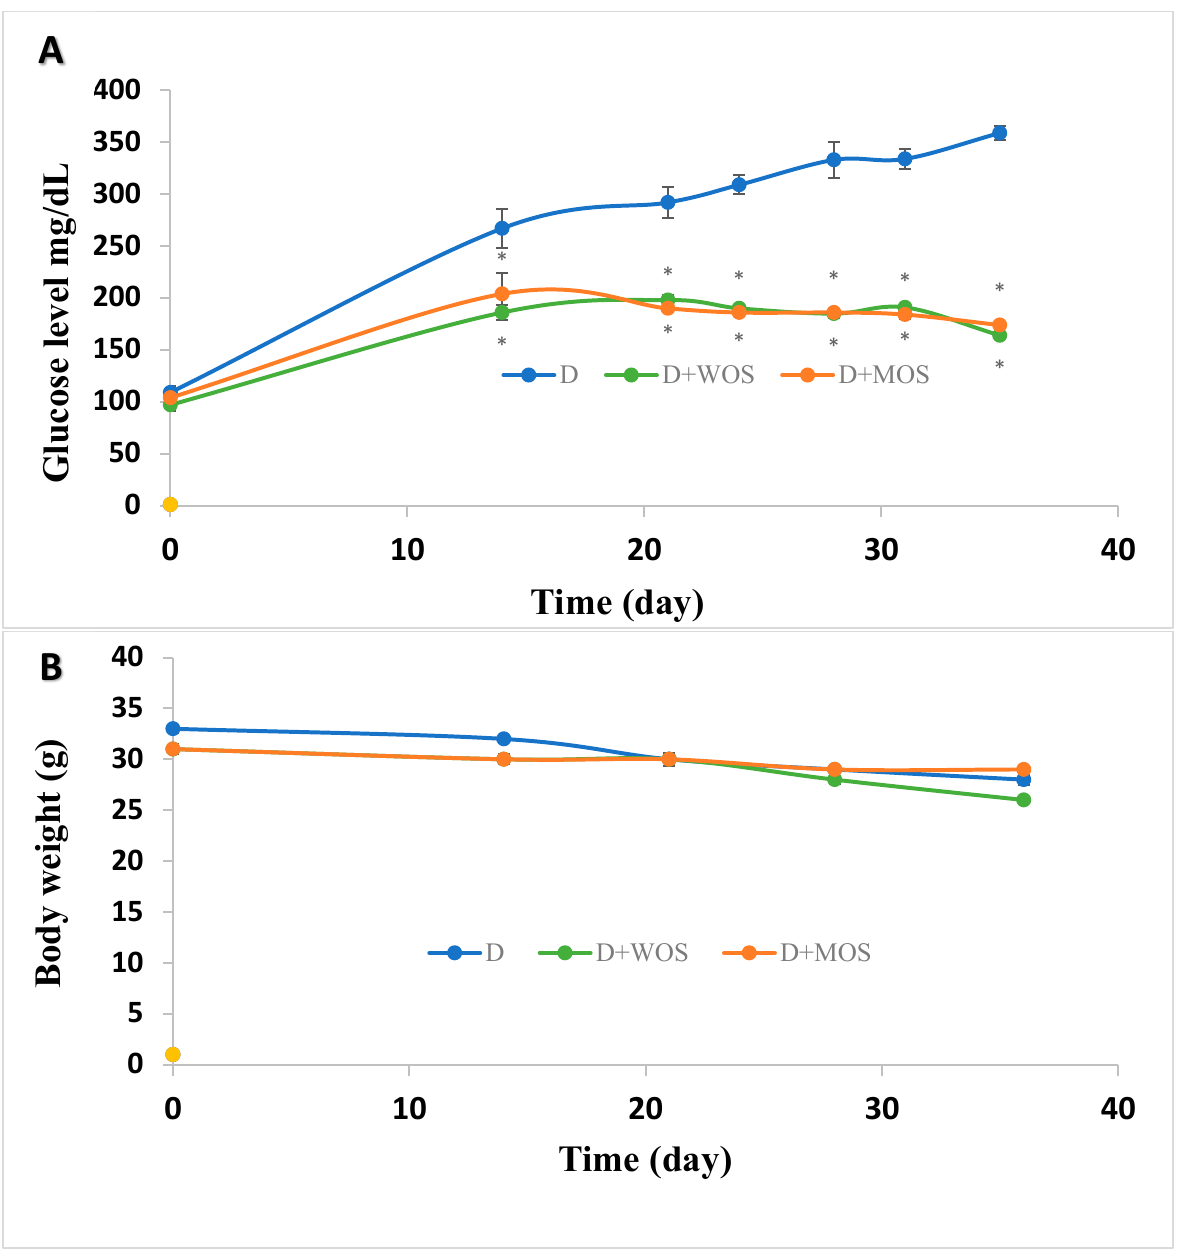
Figure 4. The effect of oral administration of 100 mg/kg WOS and MOS on blood glucose levels ( A ) and body weight ( B ) of STZ-induced diabetic mice. Values are expressed as mean ± SEM. * p < 0.05, significant as compared with diabetic group .